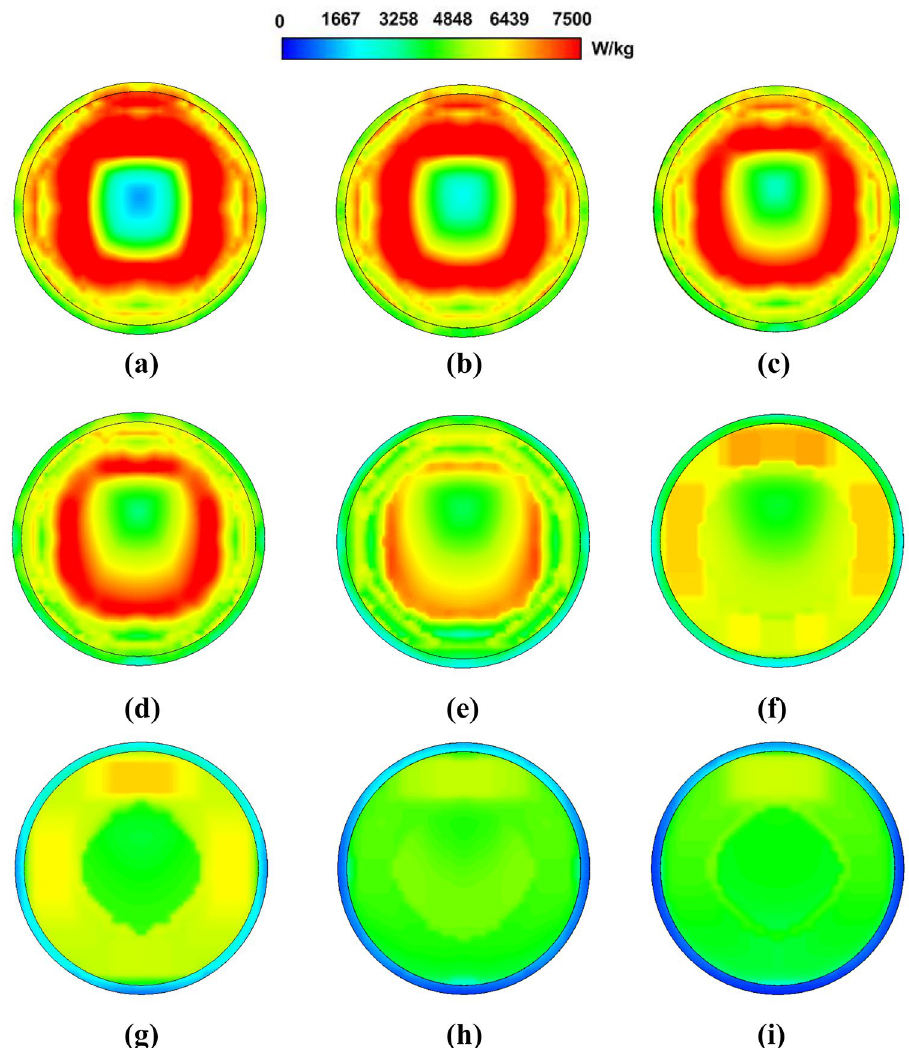
Figure 9. SAR distribution for varying cell culture volume exposures on a horizontal plane in the centre of the cell culture; ( a ) 2 ml; ( b ) 4.5 ml; ( c ) 7 ml; ( d ) 9.5 ml; ( e ) 12 ml; ( f ) 14.5 ml; ( g ) 17 ml; ( h ) 19.5 ml; ( i ) 22